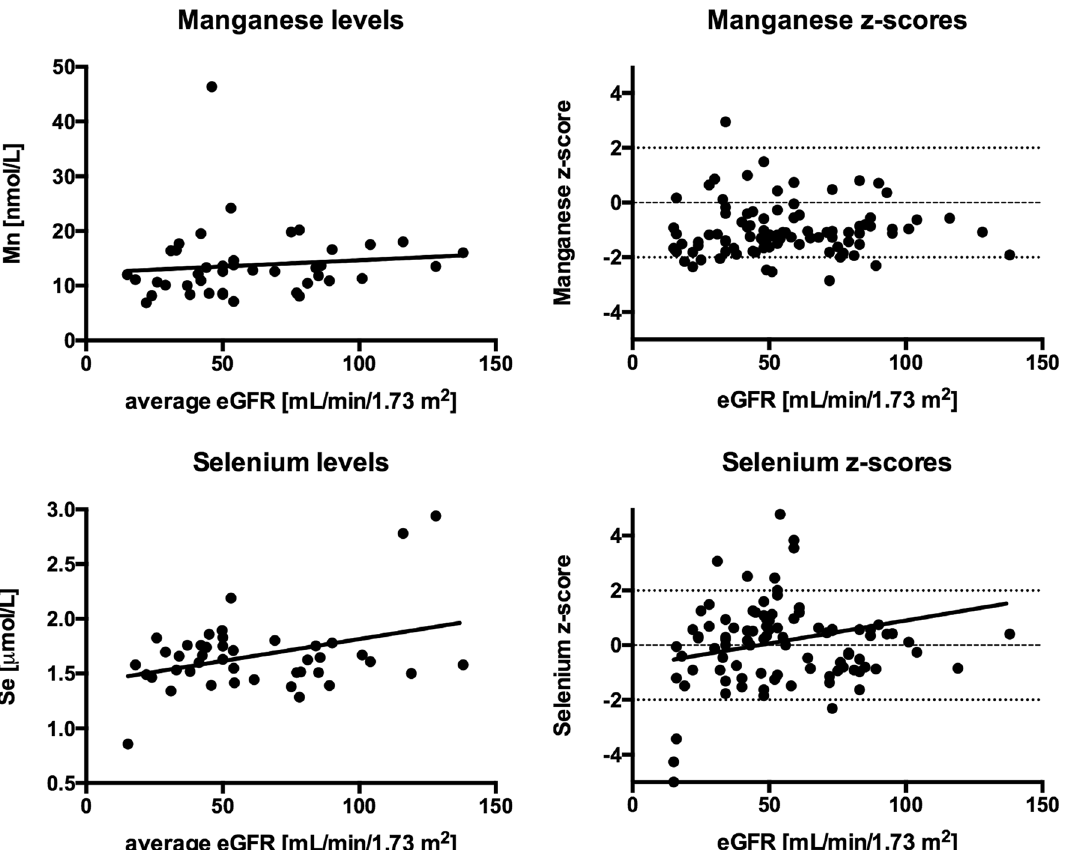
Fig. 1 The relationship between manganese, manganese z -score, selenium, and selenium z -score levels and the cystatin C